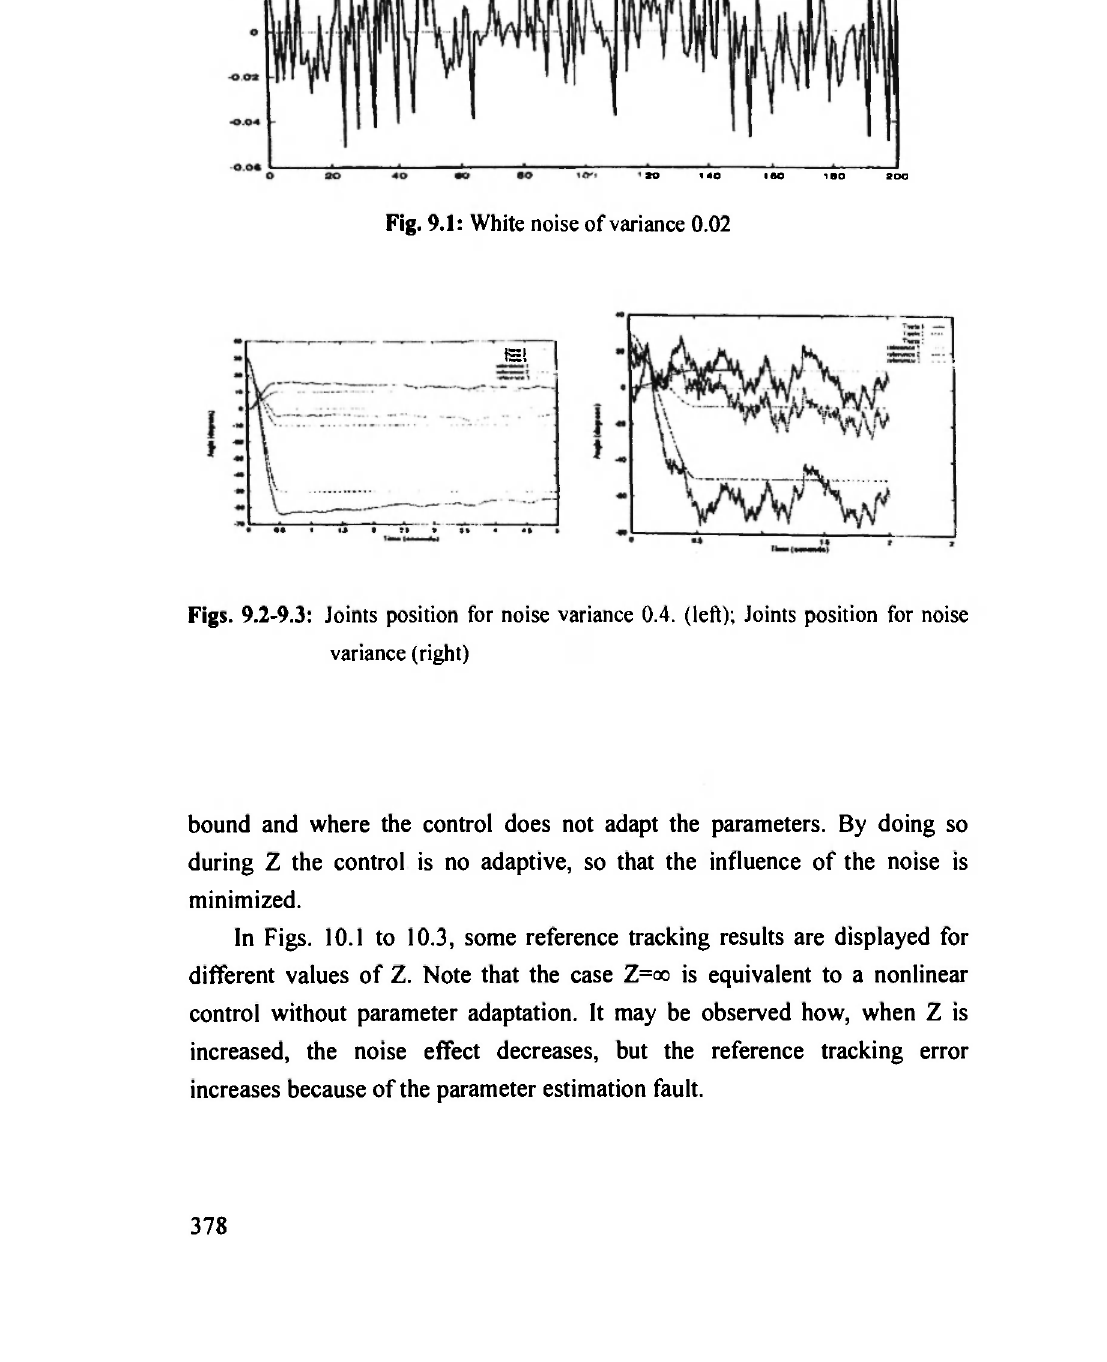
Fig. 9.1: White noise of variance 0.02